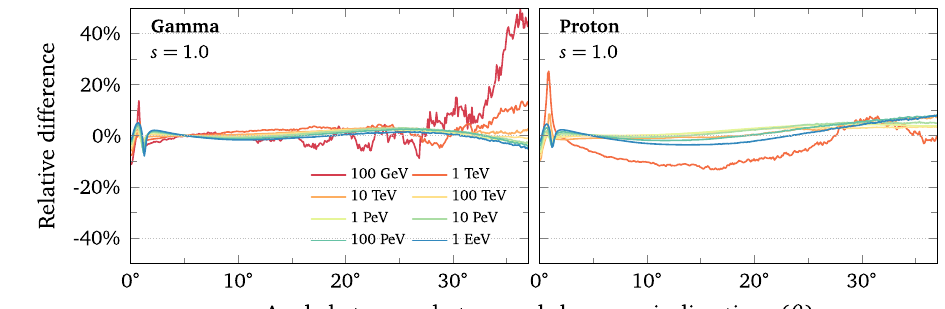
Fig. 6 Average relative deviation between parametrized and simulated angular distributions of Cherenkov photons at s = 1 . 0 for gamma-ray (left) and proton (right) showers at various primary